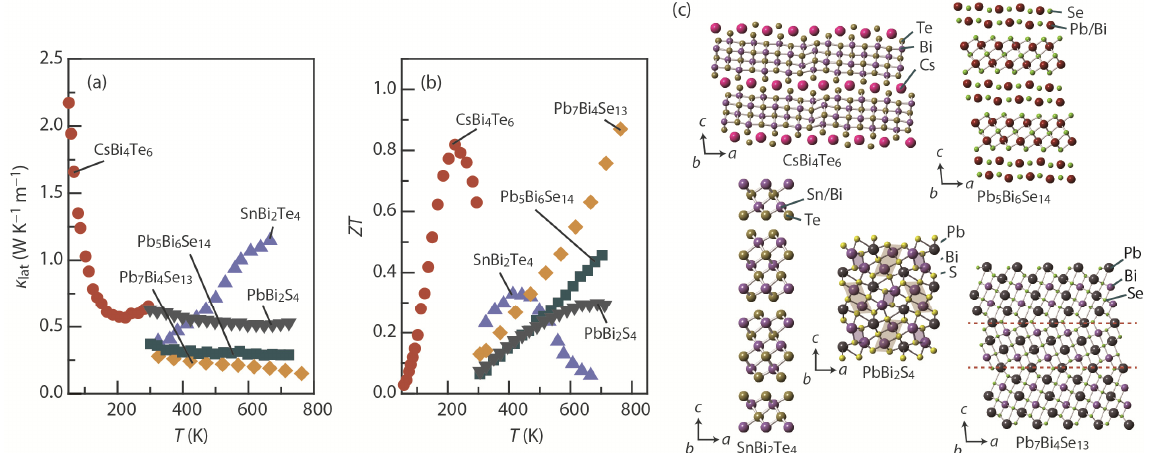
Figure 10. Temperature dependence of the ( a ) lattice thermal conductivity ( κ lat ); ( b ) thermoelectric figure of merit ( ZT ); and ( c ) crystal structure of CsBi 4 Te 6 , a member of